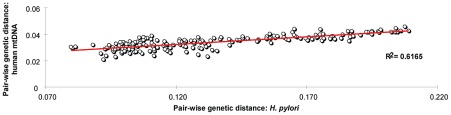
Parallel patterns of pair-wise genetic distances between human mtDNA and H. pylori gene sequences.A Mantel regression (R
2 = 0.62, P<0.0001) showed that 62% of the pair-wise genetic distances between H. pylori sequences can be accounted for by the pair-wise genetic distances between human mtDNA sequences from analogous geographic locations.